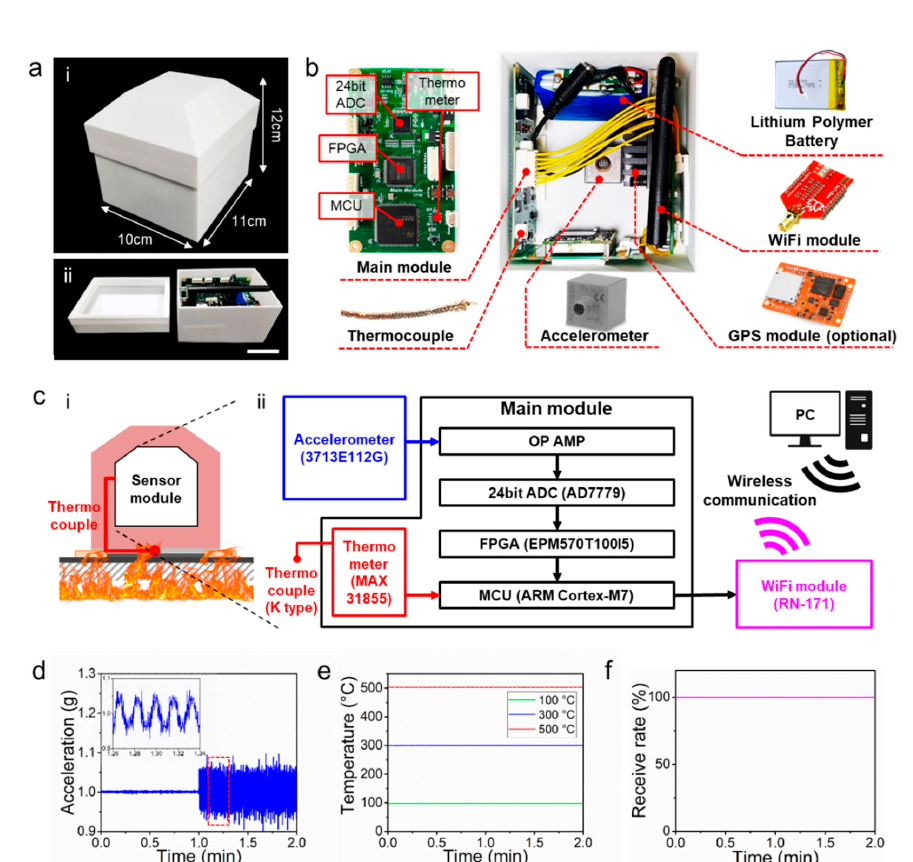
Figure 2. Configuration diagram of the sensor module and performance verification of each sensing device. ( a ) Photography of 3D printed sensor module case and its (i) dimensions and (ii) internal configuration (scale bar: 5 cm); ( b ) components of the sensor module; ( c ) conceptual drawing of (i) sensing in fire situation and (ii) schematic of sensor module and its wireless communication between the module and receiver; ( d ) performance evaluation of the accelerometer, ( e ) thermometer and ( f ) wireless